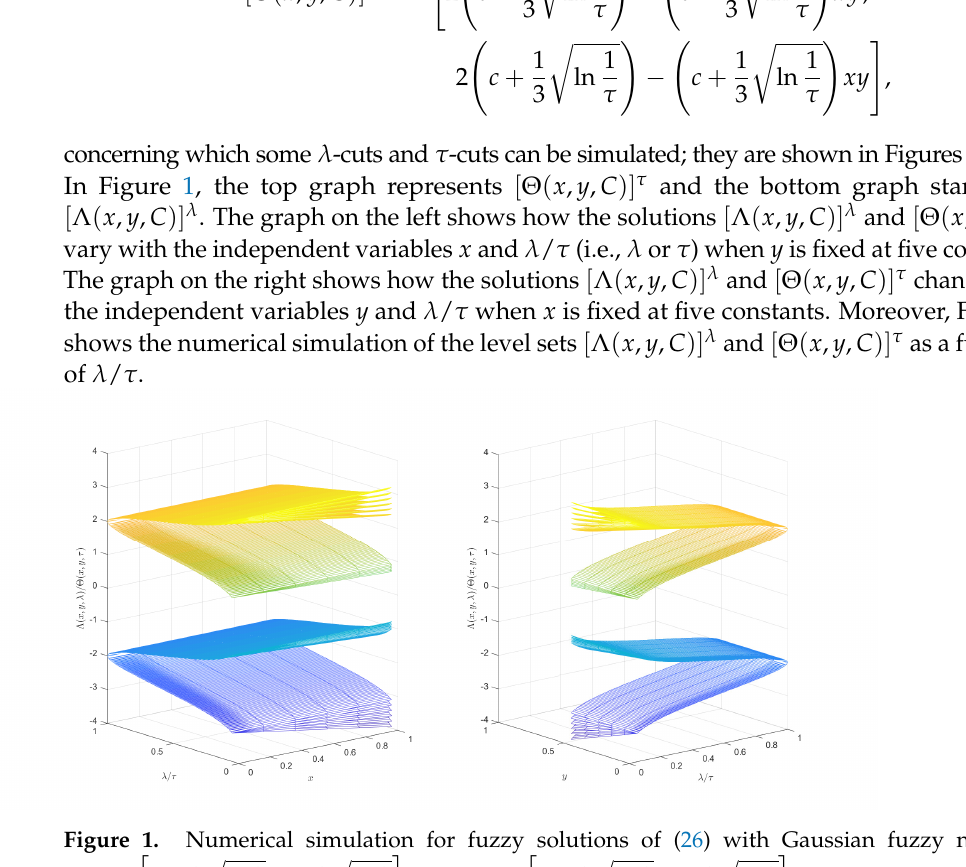
(cid:20) (cid:21) (cid:113) (cid:113) 1 − 1 ln 1 ,1 + 1 ln 1 τ τ 3 3